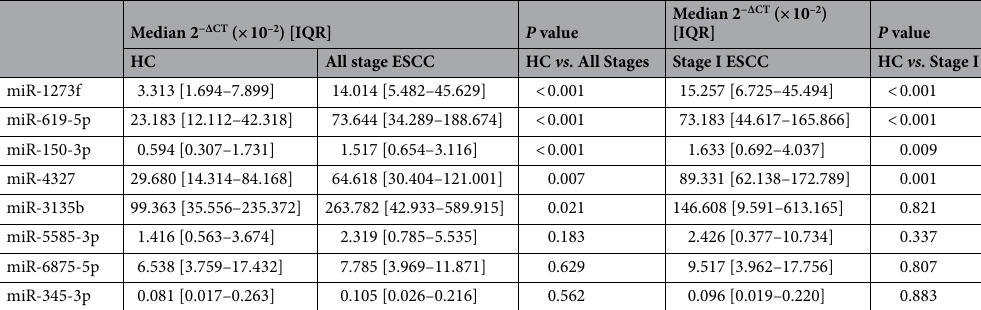
Table 2. Urinary levels of miRNAs. HC healthy control; ESCC esophageal squamous cell carcinoma; IQR interquartile range.